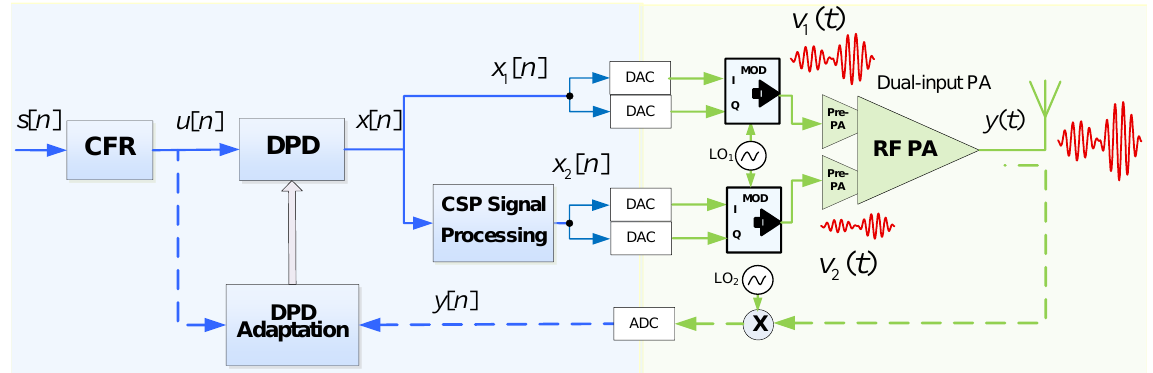
Figure 5. Block diagram of the dual-input PA with CFR and DPD